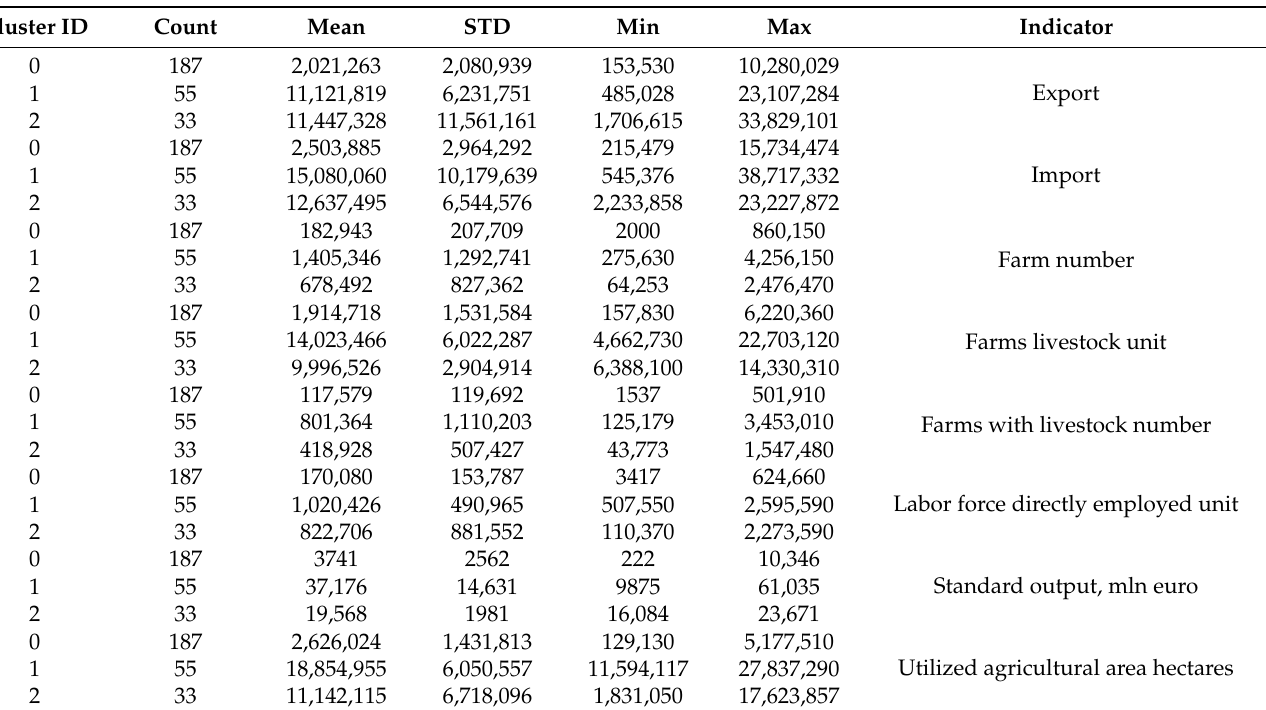
Table 3. Cluster group description by agriculture sector, created by